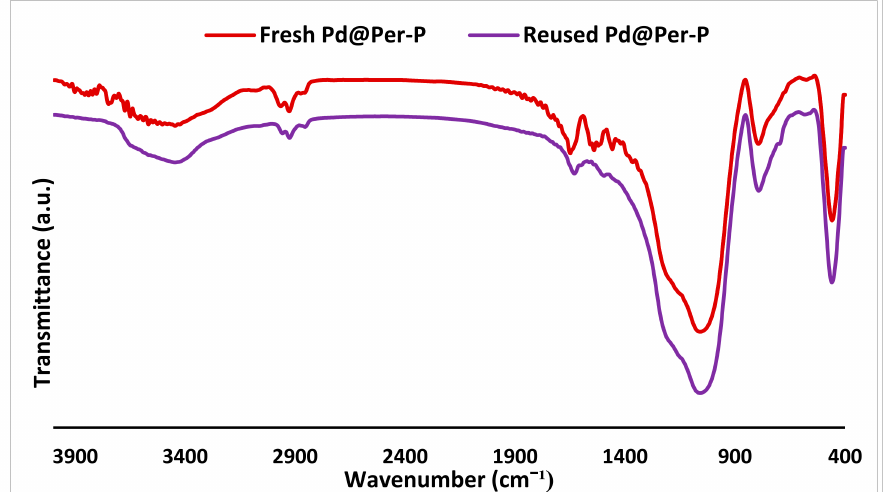
Figure 12. FTIR spectra of fresh and recycled Pd@Per-P after seven runs of the model reaction under optimum conditions.